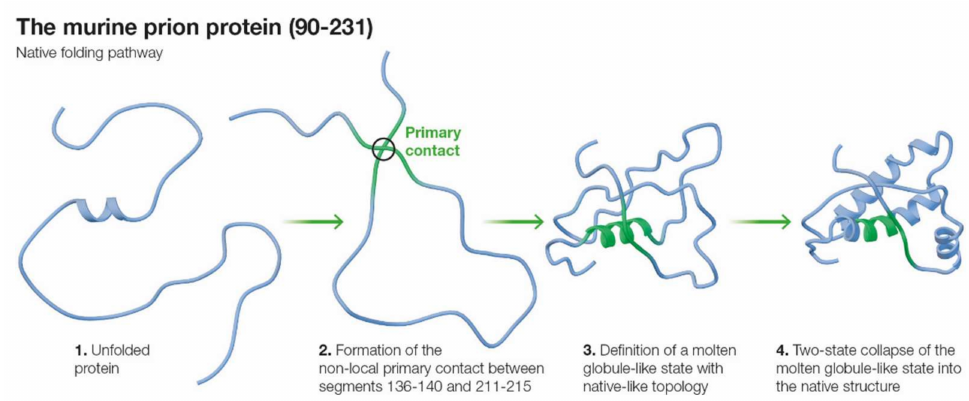
Figure 3. The native folding pathway of m PrP(90–231) predicted by the SCM. Helix 3 appears structured in MGLIS1 due to its participation in the primary contact. Stochastic search for the native topology is the rate limiting factor between the MGLIS (step 3) and the final native structure (step